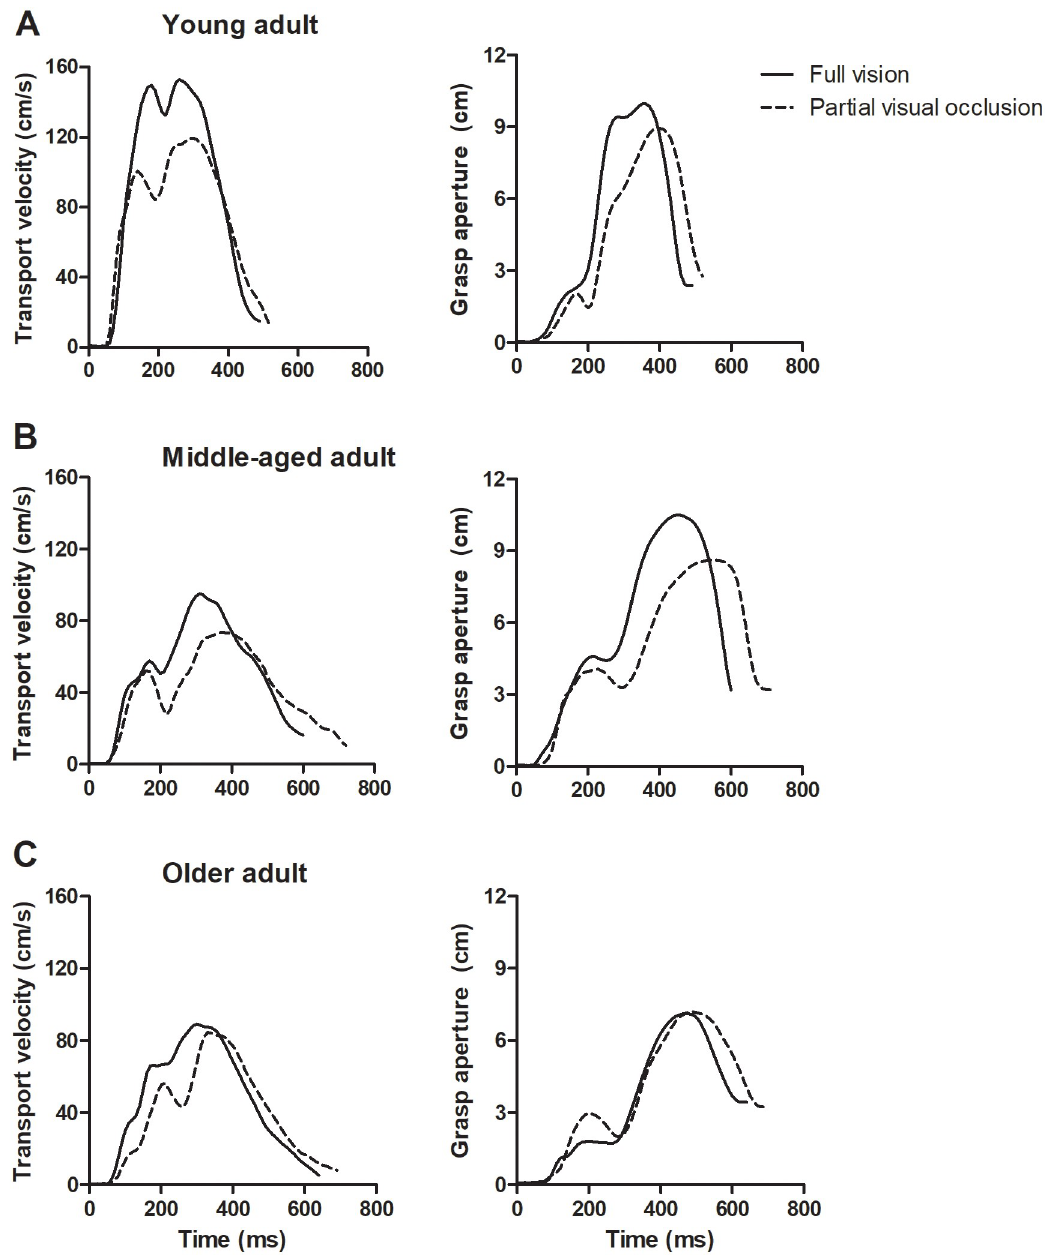
Fig 3. Transport velocity and grasp aperture profiles. Sample transport velocity and grasp aperture profiles of 2 visual conditions ( solid line full vision, dashed line partial visual occlusion) for younger adults (A), middle-aged adults (B) and older adults (C).